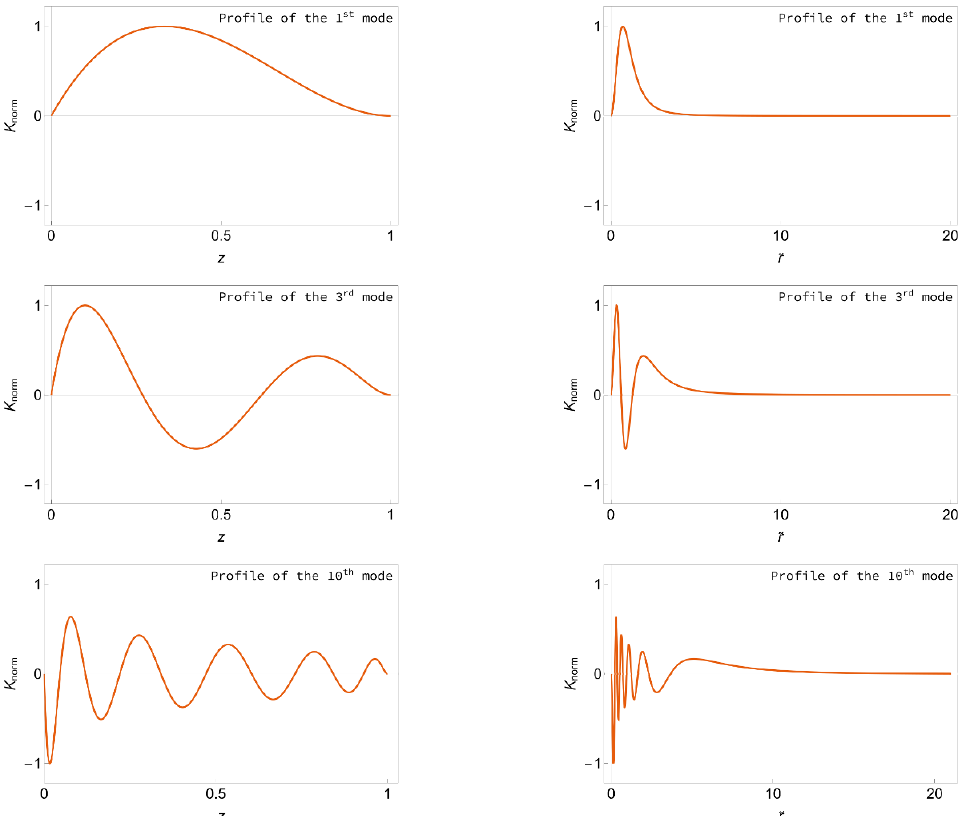
Figure 2 . Analytic radial wavefunctions at large n for several scalar excitation modes of an asymptotically AdS 2 (1 ; 0 ; n ) superstratum with b = 1, n (cid:29) 1, p = q 1 = q 2 = 1 and l = 2.